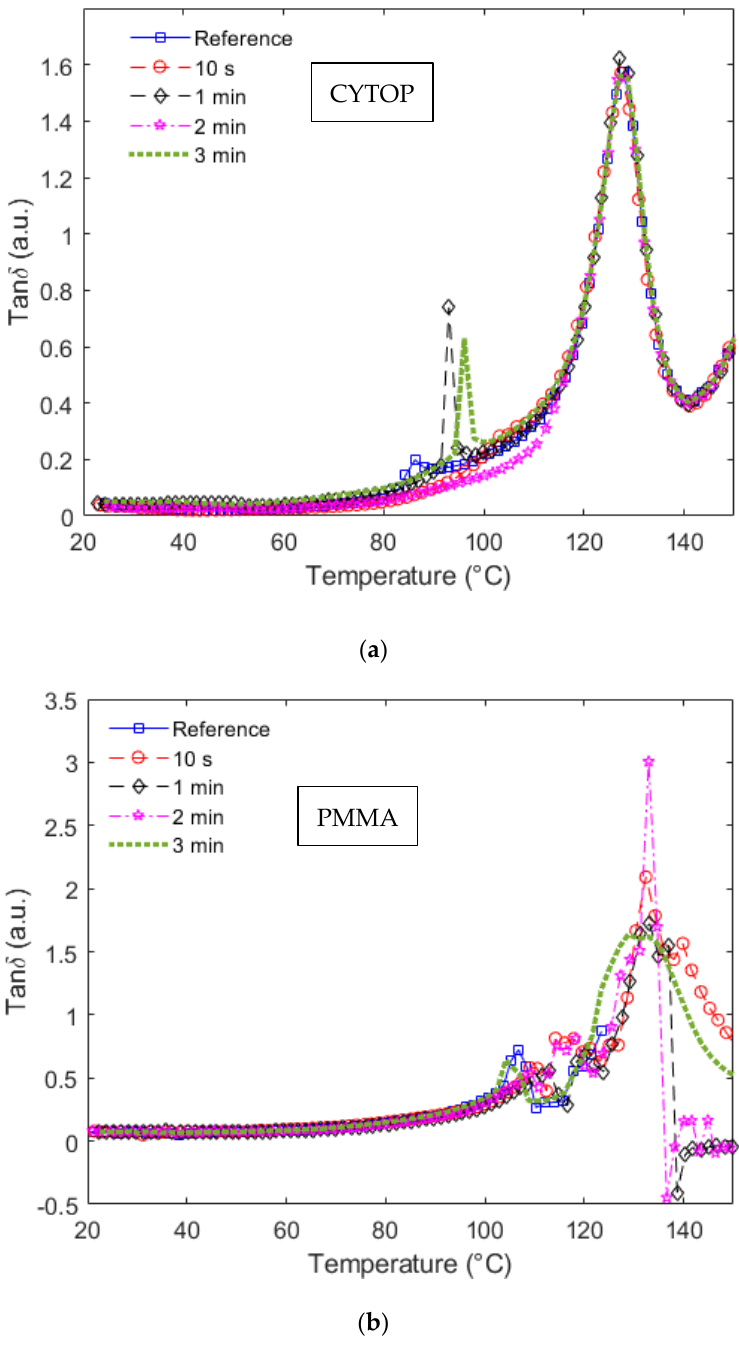
Figure 5. tan δ as a function of the temperature at each UV radiation condition for ( a ) CYTOP and ( b ) PMMA fiber.